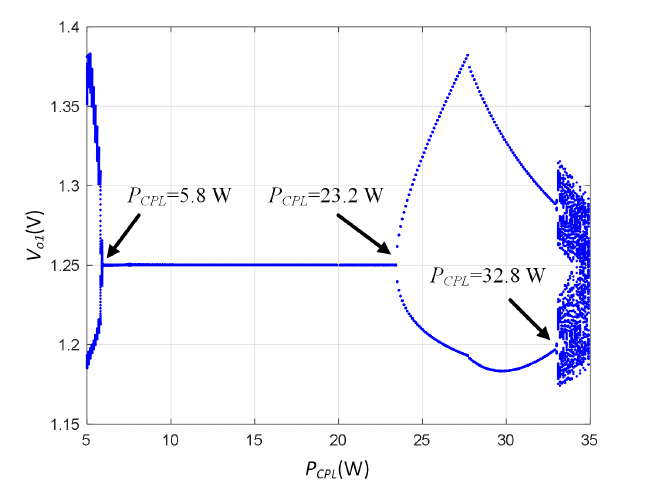
Figure 5. Bifurcation diagram of P CPL from 5 to 35